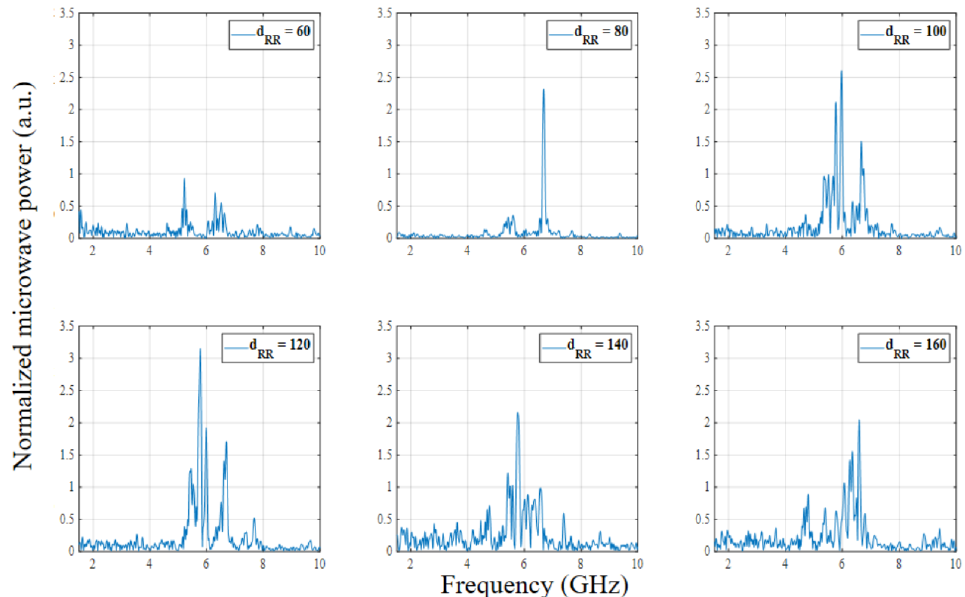
Figure 6. Frequency spectrum of the axial vircator with and without the ring reflector.